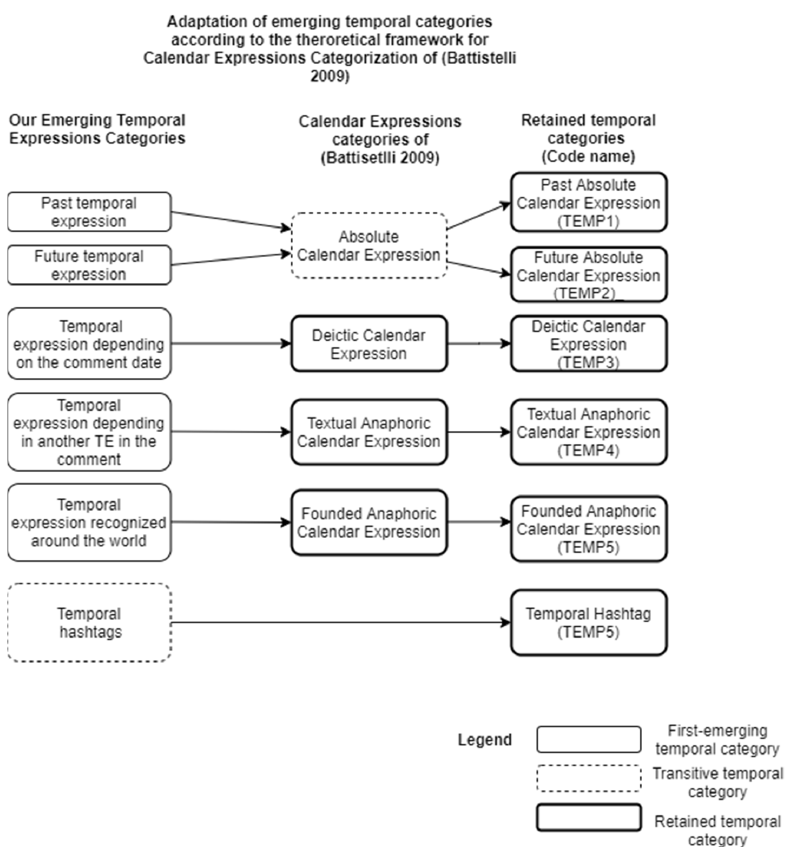
Figure A1. Adaptation of temporal patterns to the categorization of (Battistelli 2009) (Calendar expressions categories of (Battistelli 2009) coulb be found in [28]).